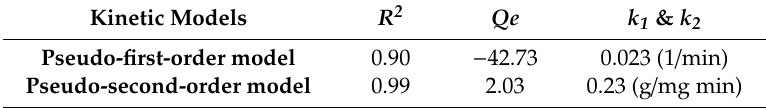
Table 4. Illustration of iron-Z-A’s kinetic parameters for adsorption of